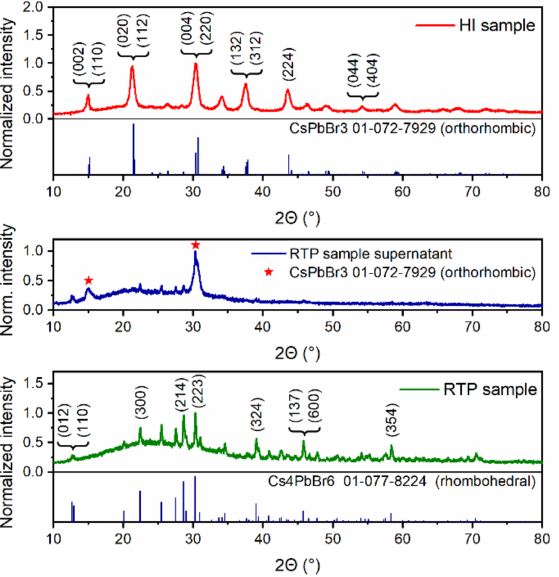
Figure 1. (From top to bottom) XRPD pattern of a precipitate of the sample prepared by the hot injection method (HI, red line) compared to the ICDD PDF-2 database record for CsPbBr 3 ; XRPD pattern of a supernatant of the sample prepared by the room-temperature precipitation method (RTP, blue line), red stars denote positions of the most intense CsPbBr 3 diffraction double lines; and XRPD pattern of a precipitate of the sample prepared by the RTP method (green line) compared to the ICDD PDF-2 database record for Cs 4 PbBr 6